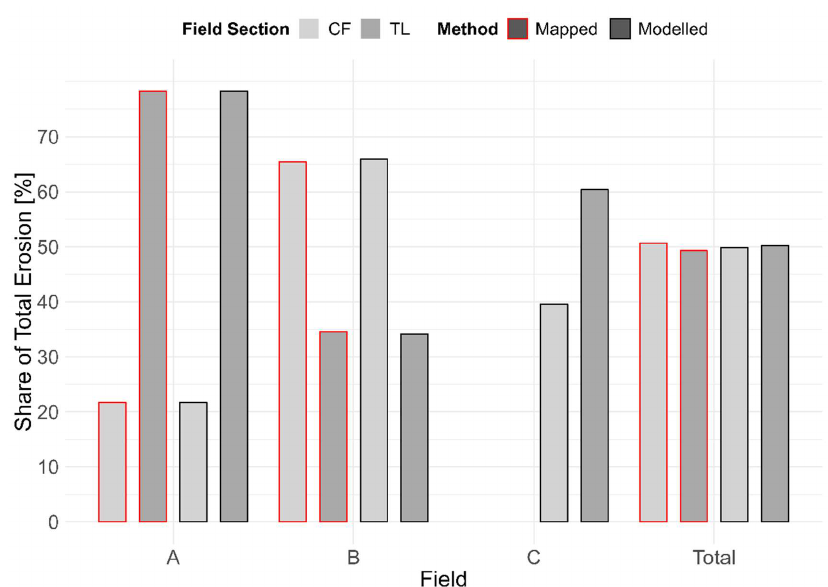
Figure 10. Mapped rill erosion (red frame) and modelled erosion (black frame) at different fields for the investigated rainfall event. Light gray boxes show erosion share of cultivated field and dark gray boxes for tramlines.